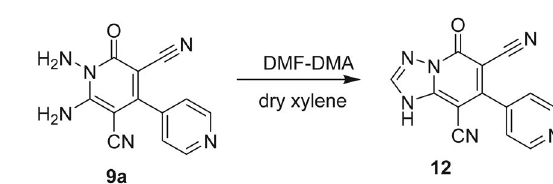
Scheme 6. Synthesis of 5-oxo-7-(pyridin-4-yl)-1,5-dihydro-[1,2,4] triazolo[1,5- a ]pyridine-6,8-dicarbonitrile ( 12)